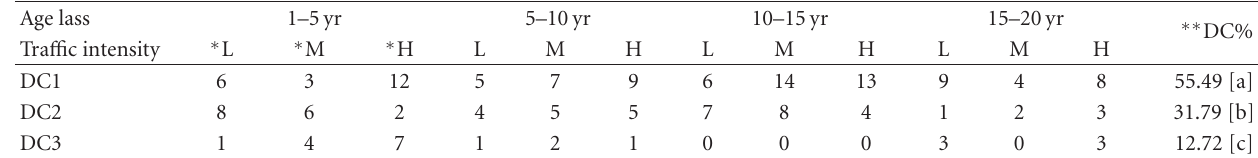
Table 5: Distribution of damaged trees’ stems based on number of wound on the stem.